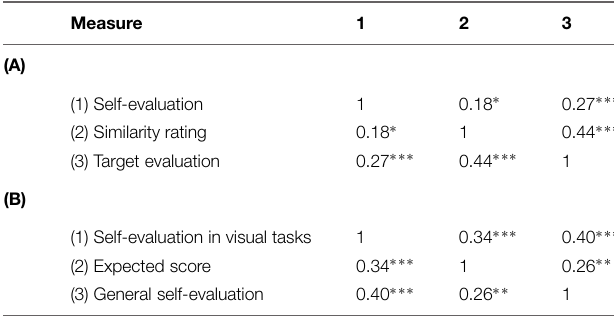
TABLE 1 | Bivariate correlations between the measures (Panel A for Experiment 1 and Panel B for Experiment 2).